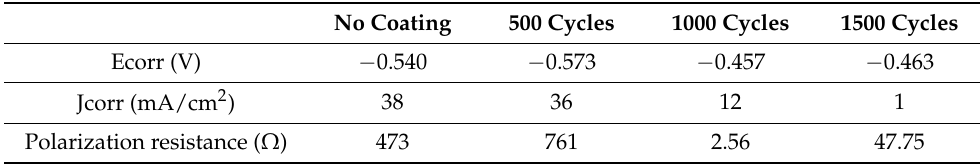
Figure 11. Variation of polarization curves in the 3.5% NaCl solution at 25 °C. There is a noticeable effect of the thickness of the ZnO layer on the reduction of corrosion processes, with a decrease in the Jcorr value from 38 mA/cm 2 for the uncovered sample to 1 mA/cm 2 for the sample given 1500 cycles (Table 3). Additionally, after obtaining the appropriate thickness, the ZnO layer stabilizes the corrosion potential at a higher level, which also limits the speed of corrosion processes. In the discussed case, this corresponds to the thickness of the coating achieved after about 1000 cycles and a potential of − 0.46 V. Table 3. Results of electrochemical